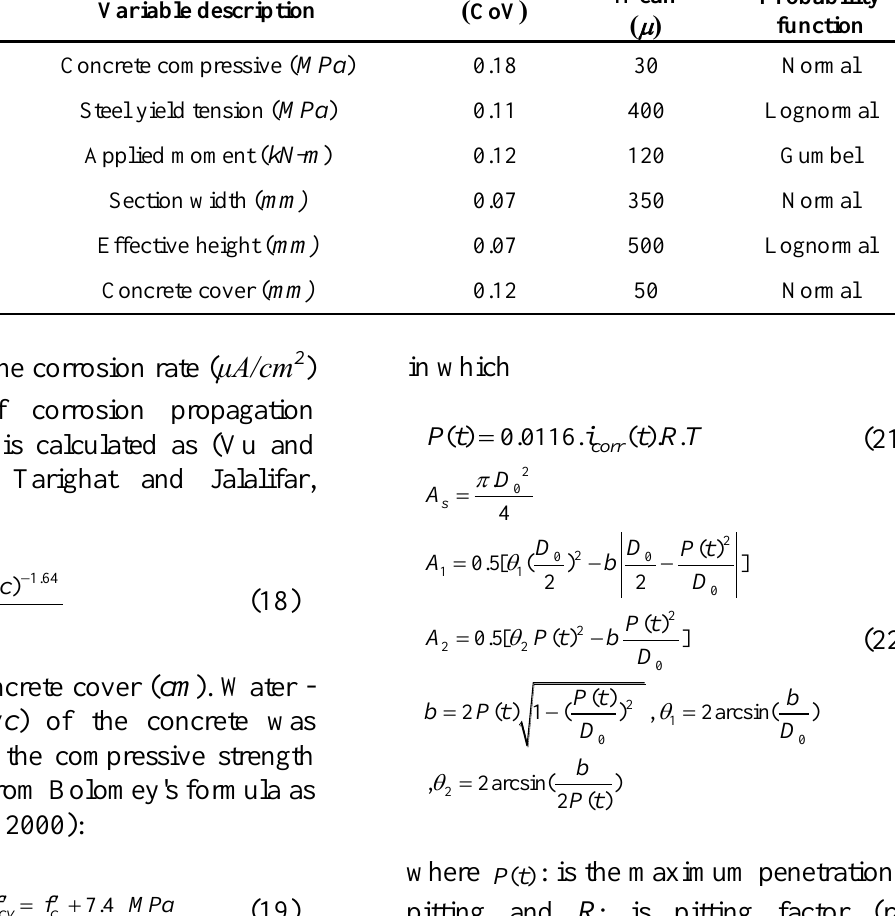
Table 3. Statistical characteristics of resistance, beam dimensions and load variables